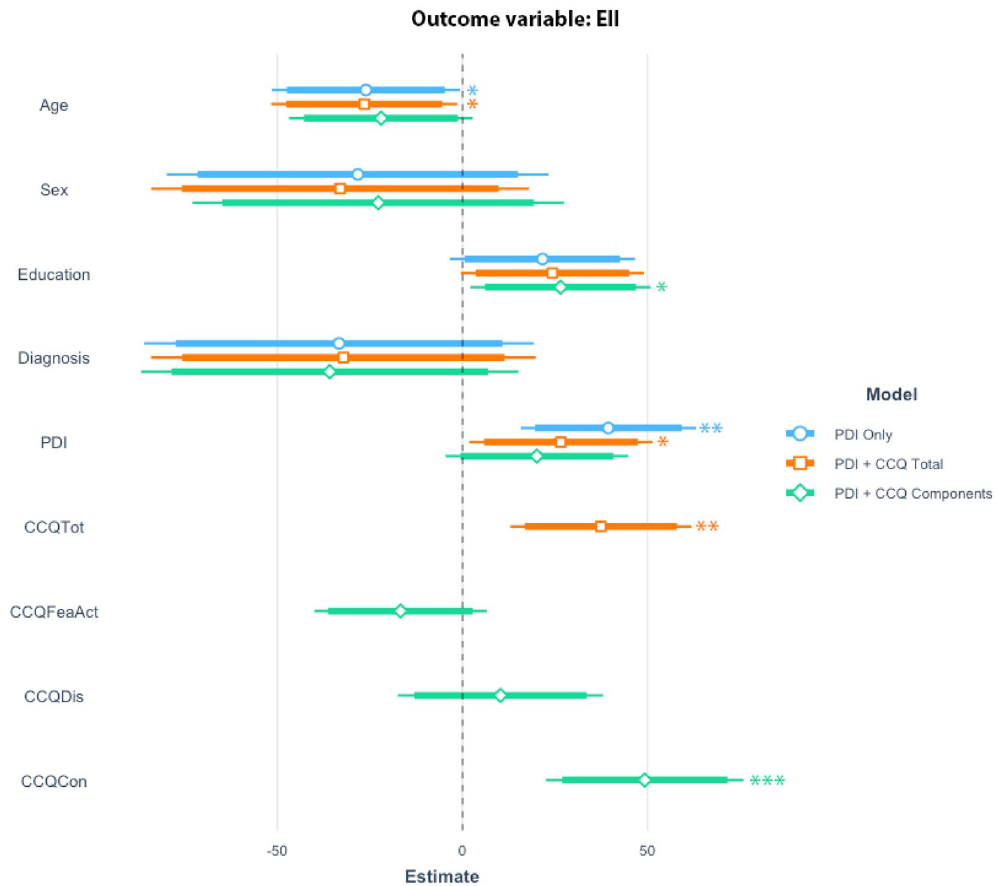
Figure 2. Regression coefficient plot for all three models with PDI (PDI Only), CCQ Total (PDI + CCQ Total) and CCQ components (PDI + CCQ Components) as predictors of EII (BADE). The figure shows the results of the different models, which gets increasingly complex, first model only shows only PDI whereas the second model shows the total CCQ-score, and the last and third model shows the score of the CCQ components, * p < 0.05, ** p < 0.01, *** p <